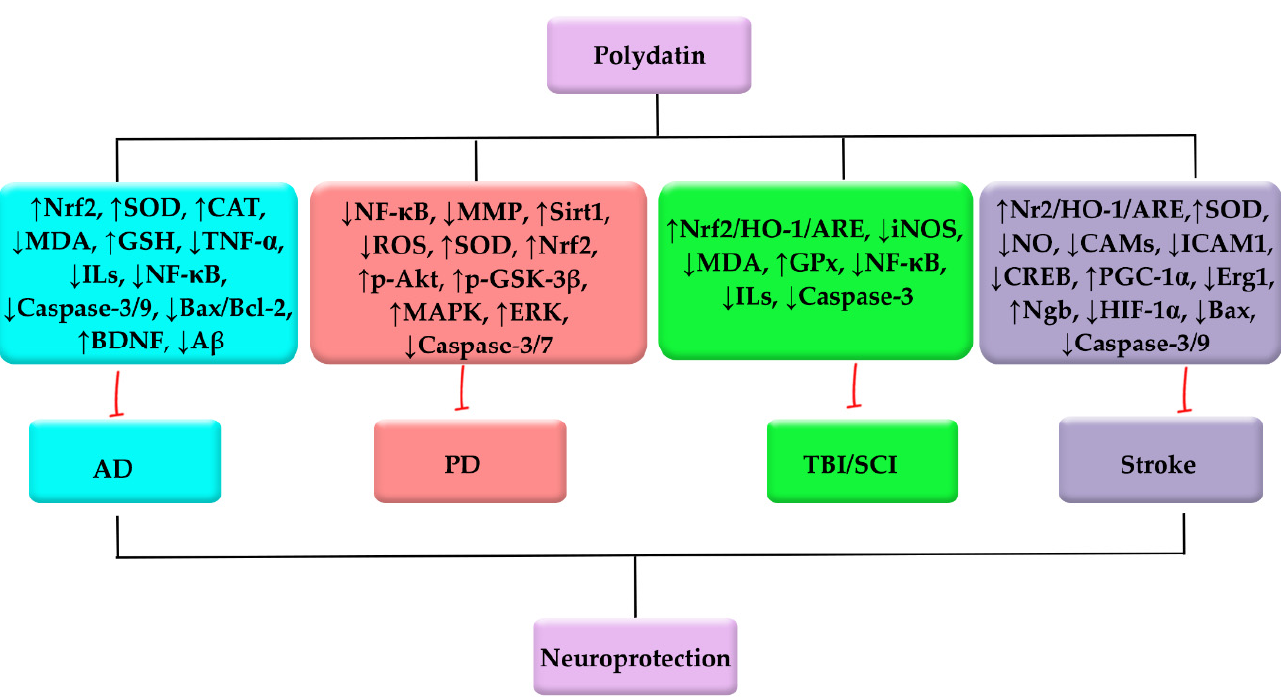
Figure 2. Polydatin employs several mediators to combat PD, AD, TBI/SCI, and stroke. Table 1. Neuropharmacological mechanisms of polydatin against different NDDs.